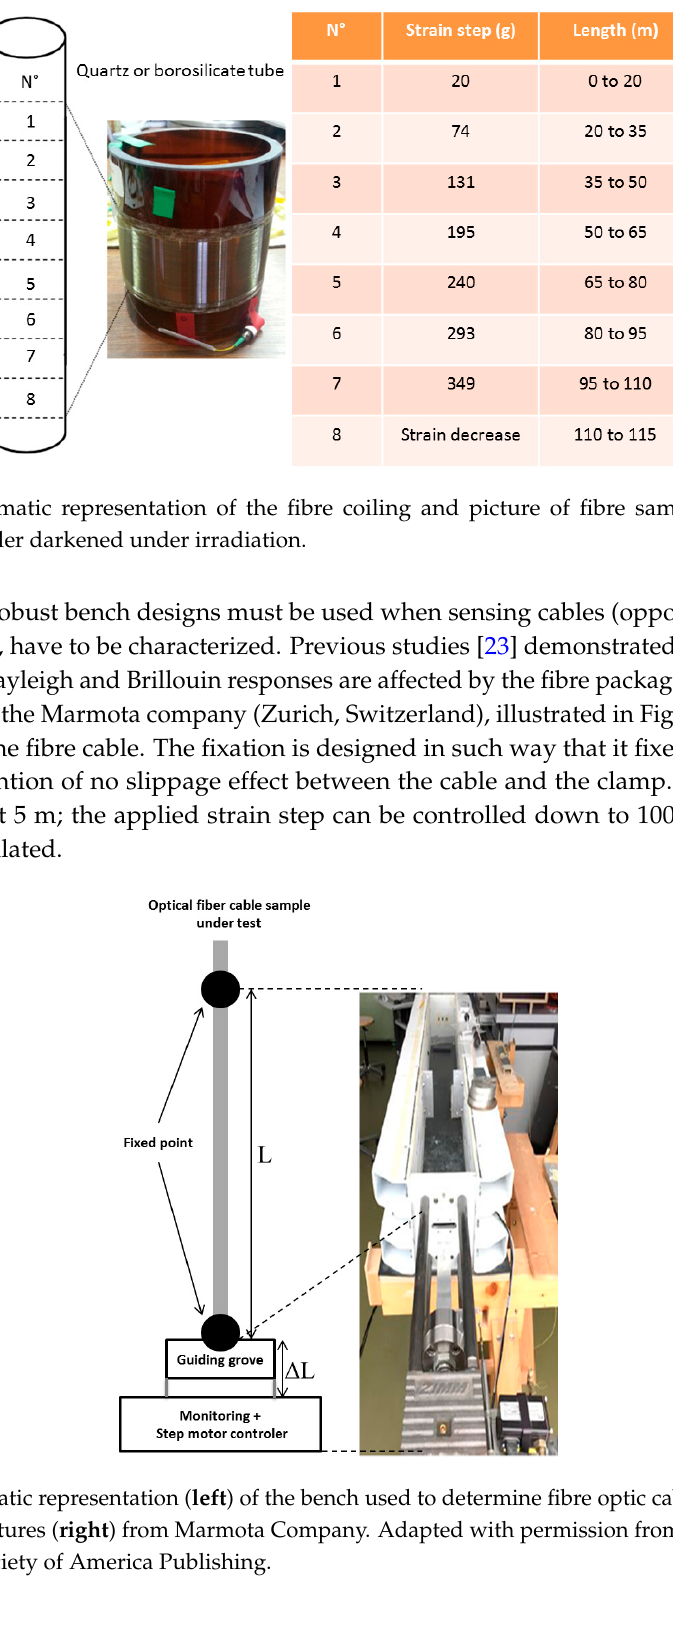
Figure 8. Schematic representation ( left ) of the bench used to determine fibre optic cables’ sensitivities to strain and pictures ( right ) from Marmota Company. Adapted with permission from [23]. Copyright 2016 Optical Society of America Publishing.